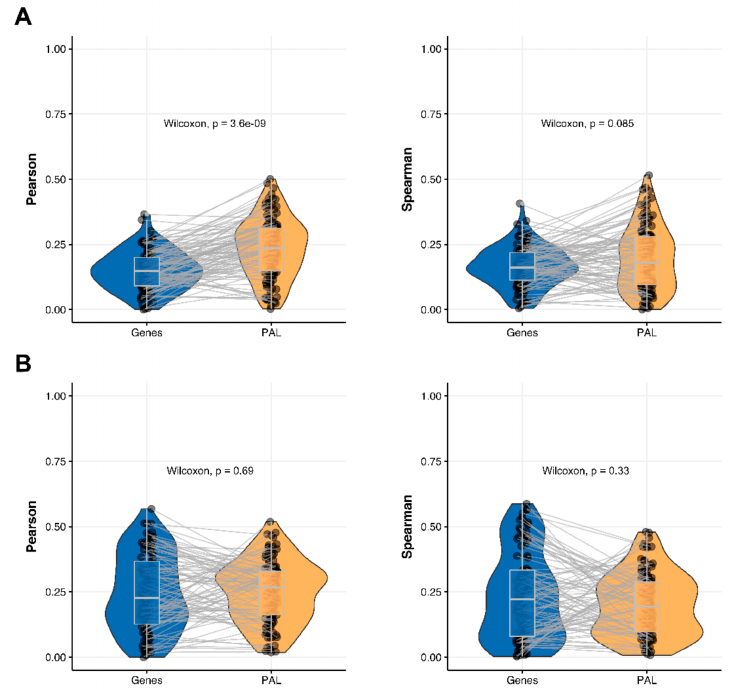
Figure 9. Paired gene-to-gene and PAL-to-PAL correlation between RNA and protein expression levels estimated within Pancreatic Ductal Adenocarcinoma biosamples using Pearson ( left ) and Spearman ( right ) correlation coefficients for ( A ) the total set of genes and molecular pathways; ( B ) the set of drug target genes and molecular pathways [17].